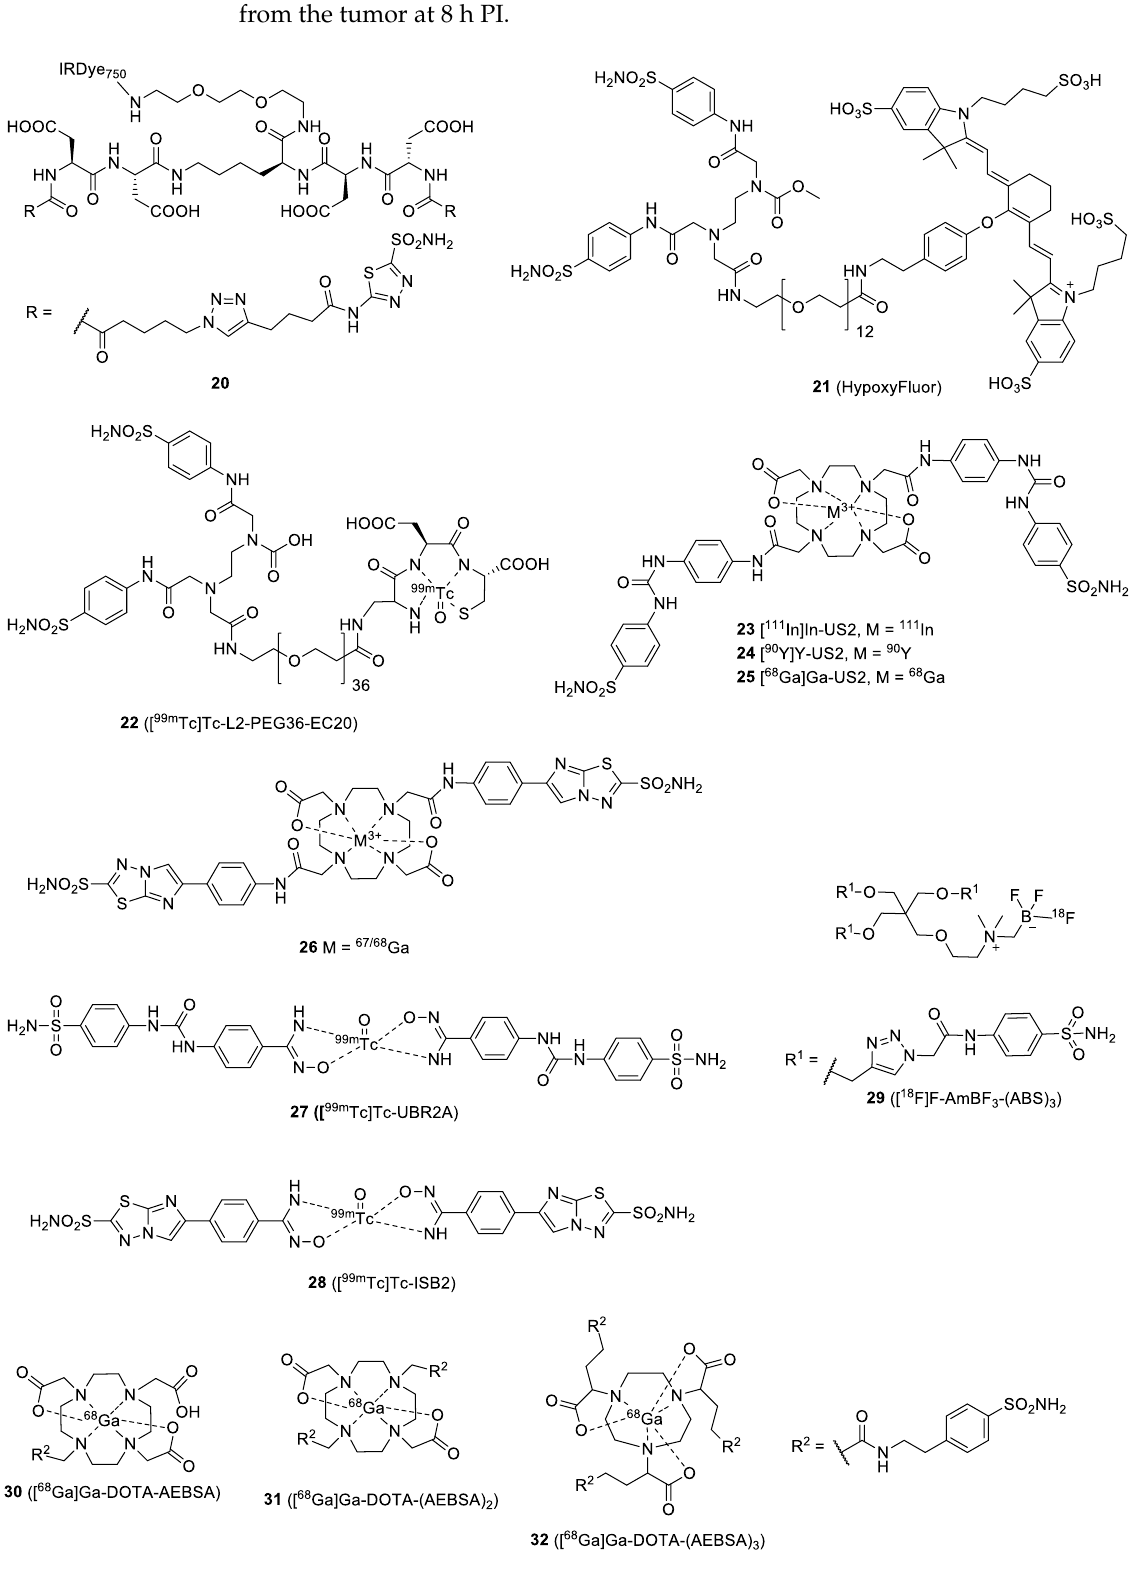
Figure 10. Chemical structures of published multivalent CAIX ligands.